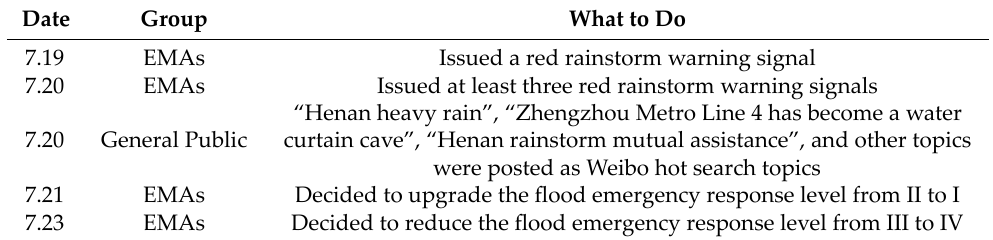
Table 1. Five important fragments of the “July 20 Heavy rainstorm in Zhengzhou”.